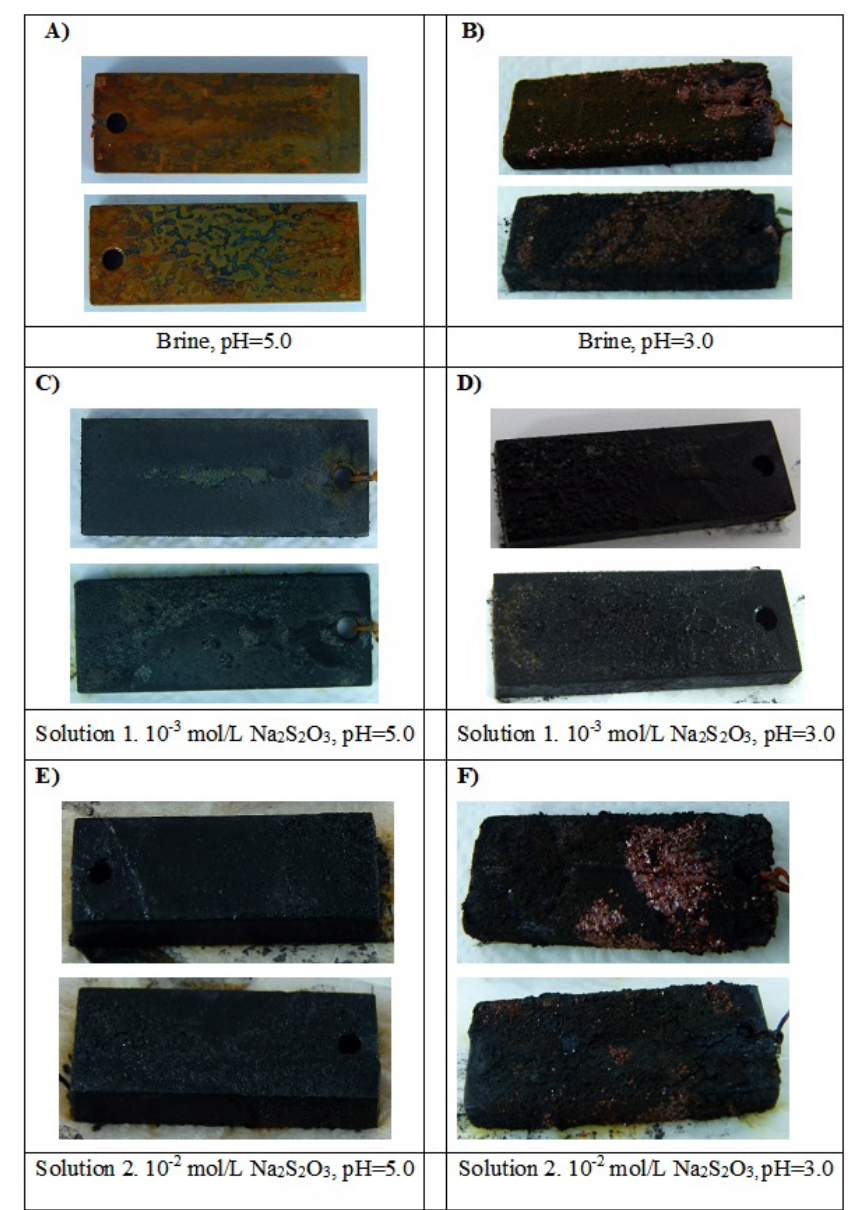
Figure 4. Surface aspect of the weight loss test specimens before removal of corrosion products.